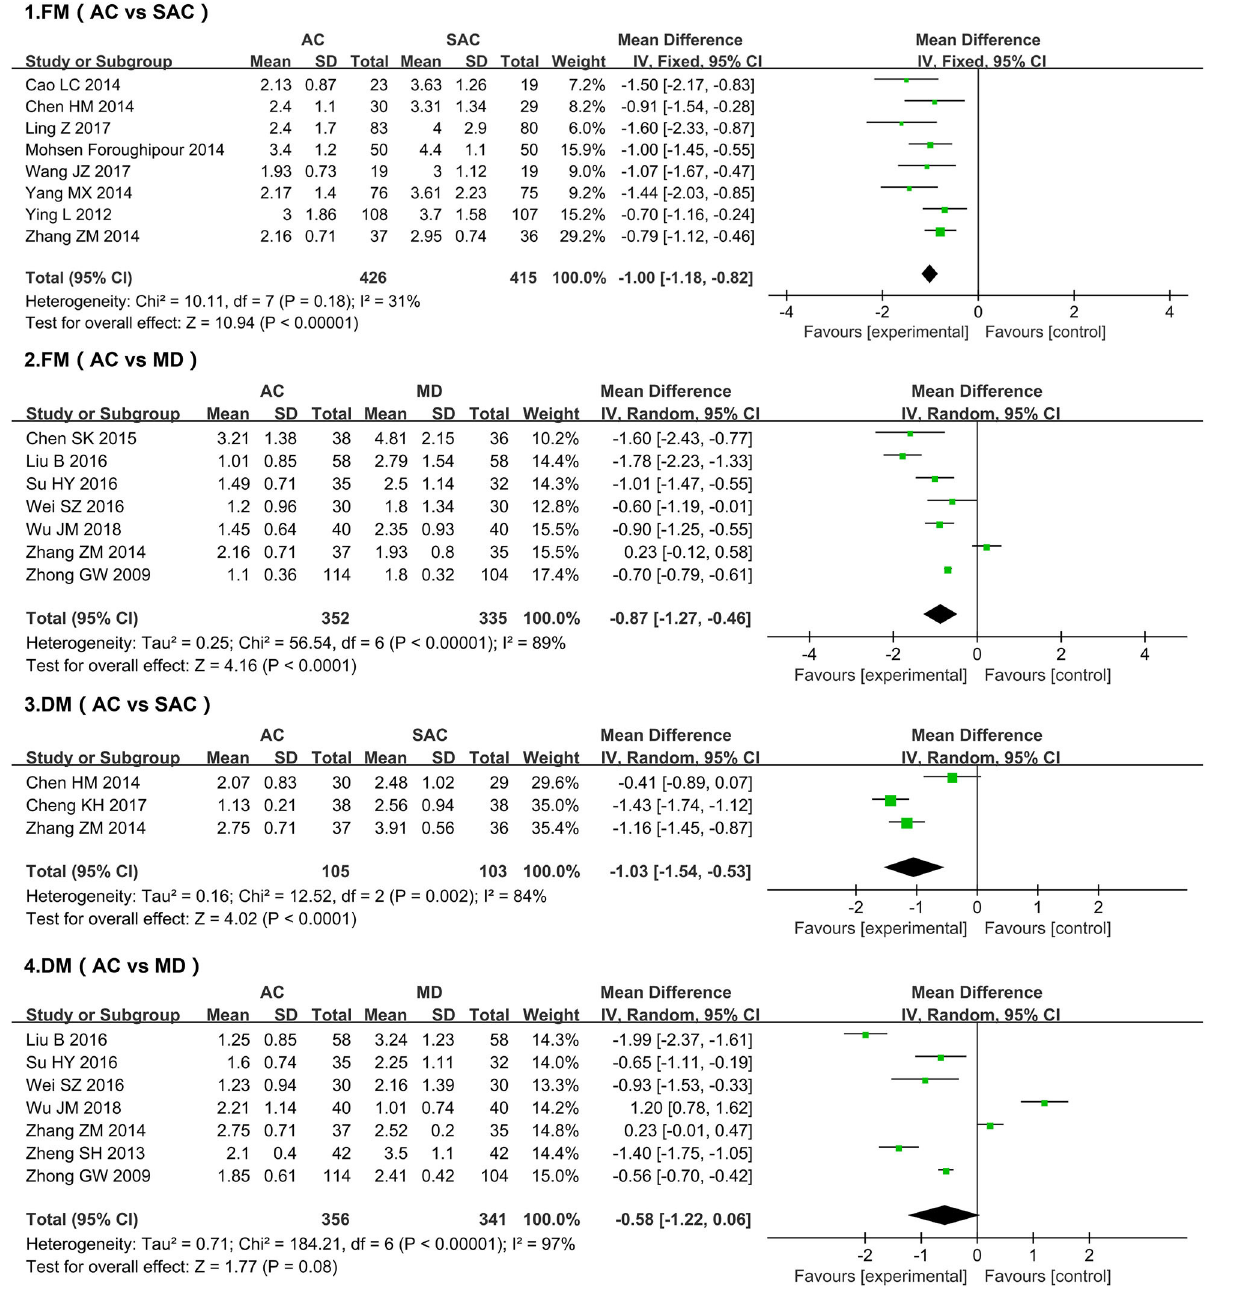
medication (mainly ergotamine and flunarizine hydrochloride) (29, 36–39). All five studies examined blood flow velocity in the bilateral anterior cerebral artery (ACA), middle cerebral artery (MCA), and posterior cerebral artery (PCA) from 0 to 1 month after treatment. The studies collectively included 457 patients. Since the heterogeneity of the three groups of data, as determined by the chi-square test, was